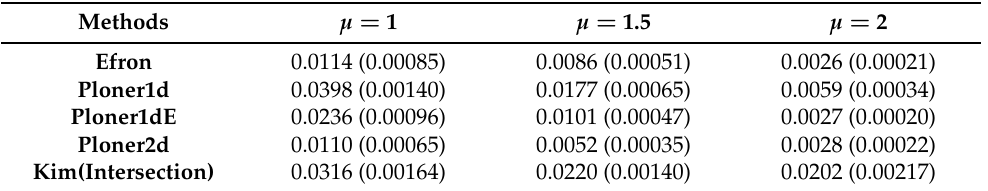
Table 3. Mean shift scenario (two-sided alternative): means and standard errors of estimated FDRs over 100 repetitions (cutoff =